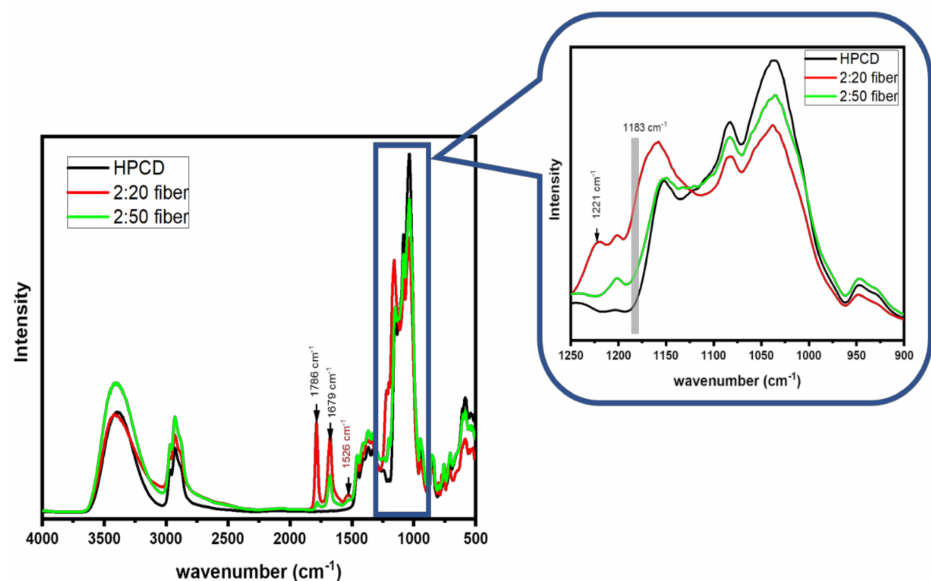
Figure 2. FT-IR spectra of HPCD and as-spun Chi:HPCD fiber (2:20 and 2:50, respectively) without normalization. The expanded region of the inset spectra is shown between 1250 and 900 cm − 1 of the original spectra.